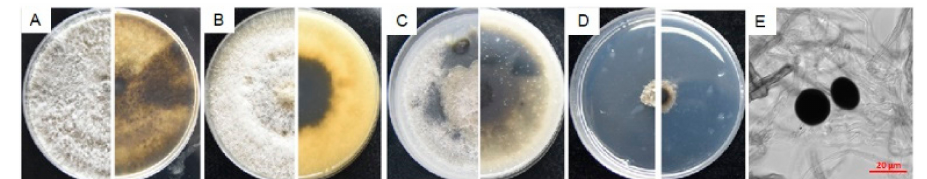
Figure 7. Morphological characteristics of Nigrospora oryzae isolate N9. ( A – D ) The front and back of the colony morphology on PDA, MEA, OA and WA plate; ( E ), conidia induced by ultraviolet radiation for 7 days on bayberry twigs on WA plates. Fungal mycelia and spores were observed and photographed with a Zeiss Axio observer Z1 Microscope (Carl Zeiss Microscopy,